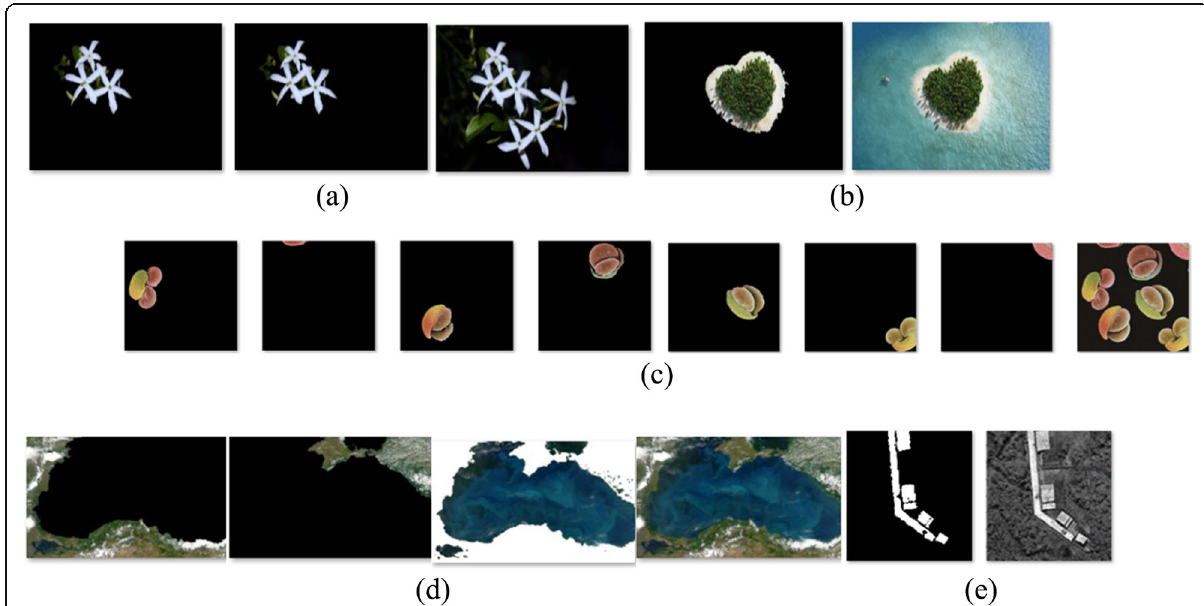
Fig. 9 Examples of segmentation results. a Plant-image segmentation result. b Island-image segmentation result. c Microorganism-image segmentation result. d Remote sensing image segmentation result. e Remote sensing image segmentation